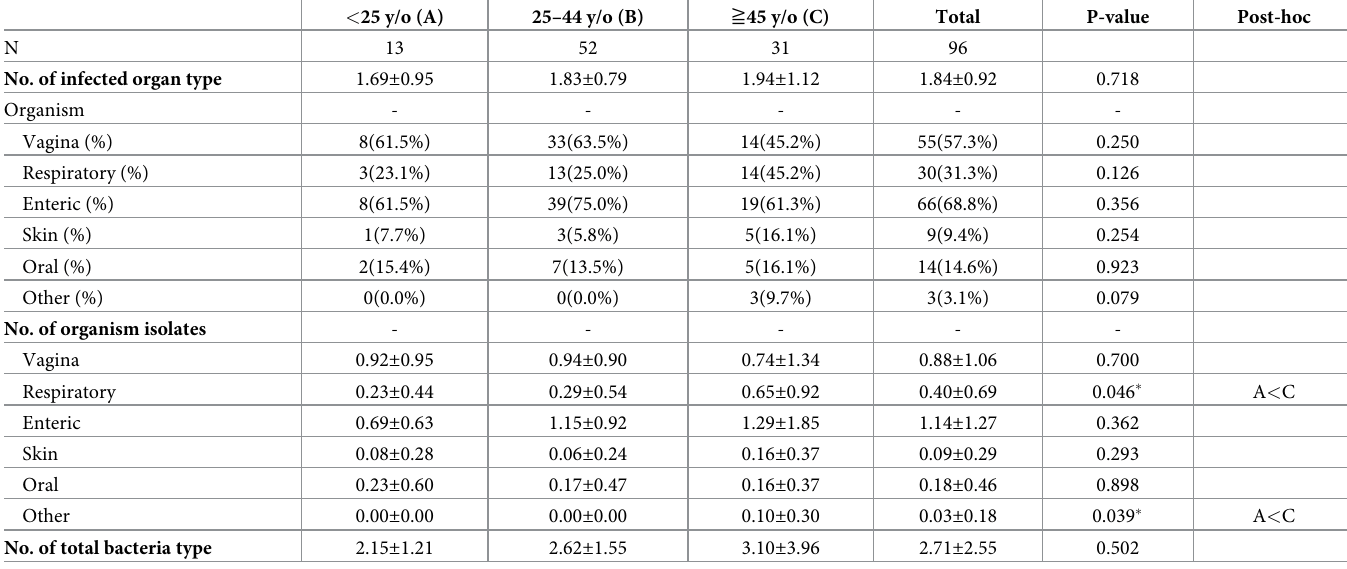
Table 2 shows the numbers and percentages of different categorical pathogens in PID patients among the three groups. There were 318 isolated microorganisms. There were six sub- groups of pathogens, including vaginal, respiratory, enteric, skin, oral, and opportunistic human infections. The most common pathogens in PID patients in the age � 45y group than in the other two groups were respiratory and other pathogens (p = 0.046 and p = 0.039, respec- tively). The vagina, enteric, skin, and oral pathogens were no significant differences among the three groups. Table 3 shows the number and percentage of different categorial pathogens in the PID patients. The Prevotella bivia (vaginal pathogens) was more common in age < 25 and 25–44 Table 2. Bacterial isolates in patients with pelvic inflammatory disease (n =